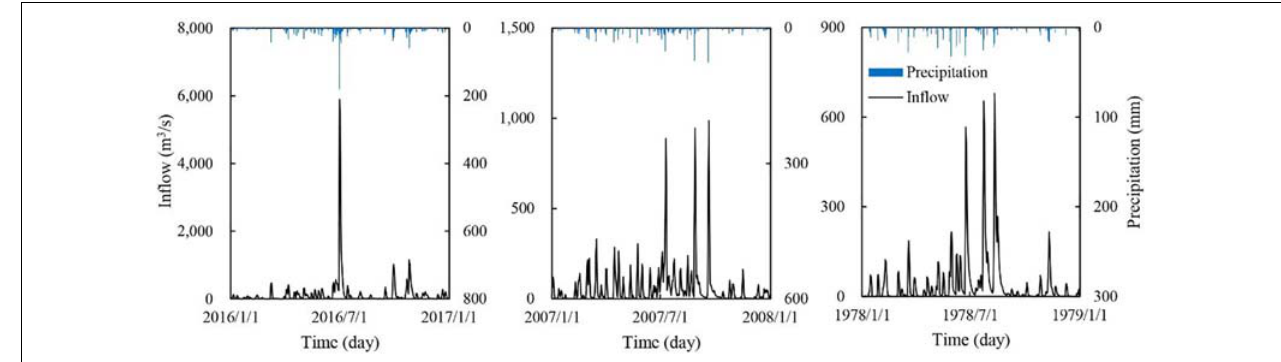
FIGURE 8 | Daily lake inflow hydrograph of the typical